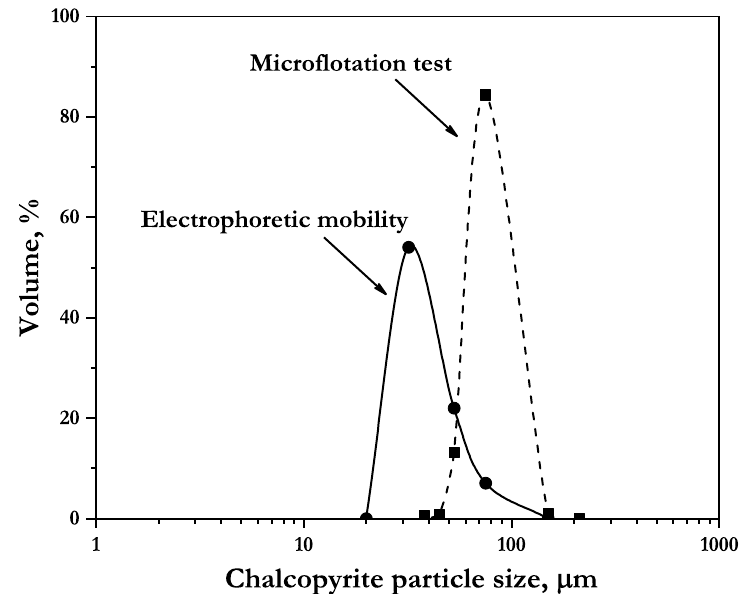
Figure 4. Particle size distribution of the chalcopyrite used for electrophoretic mobility and mi- croflotation tests.